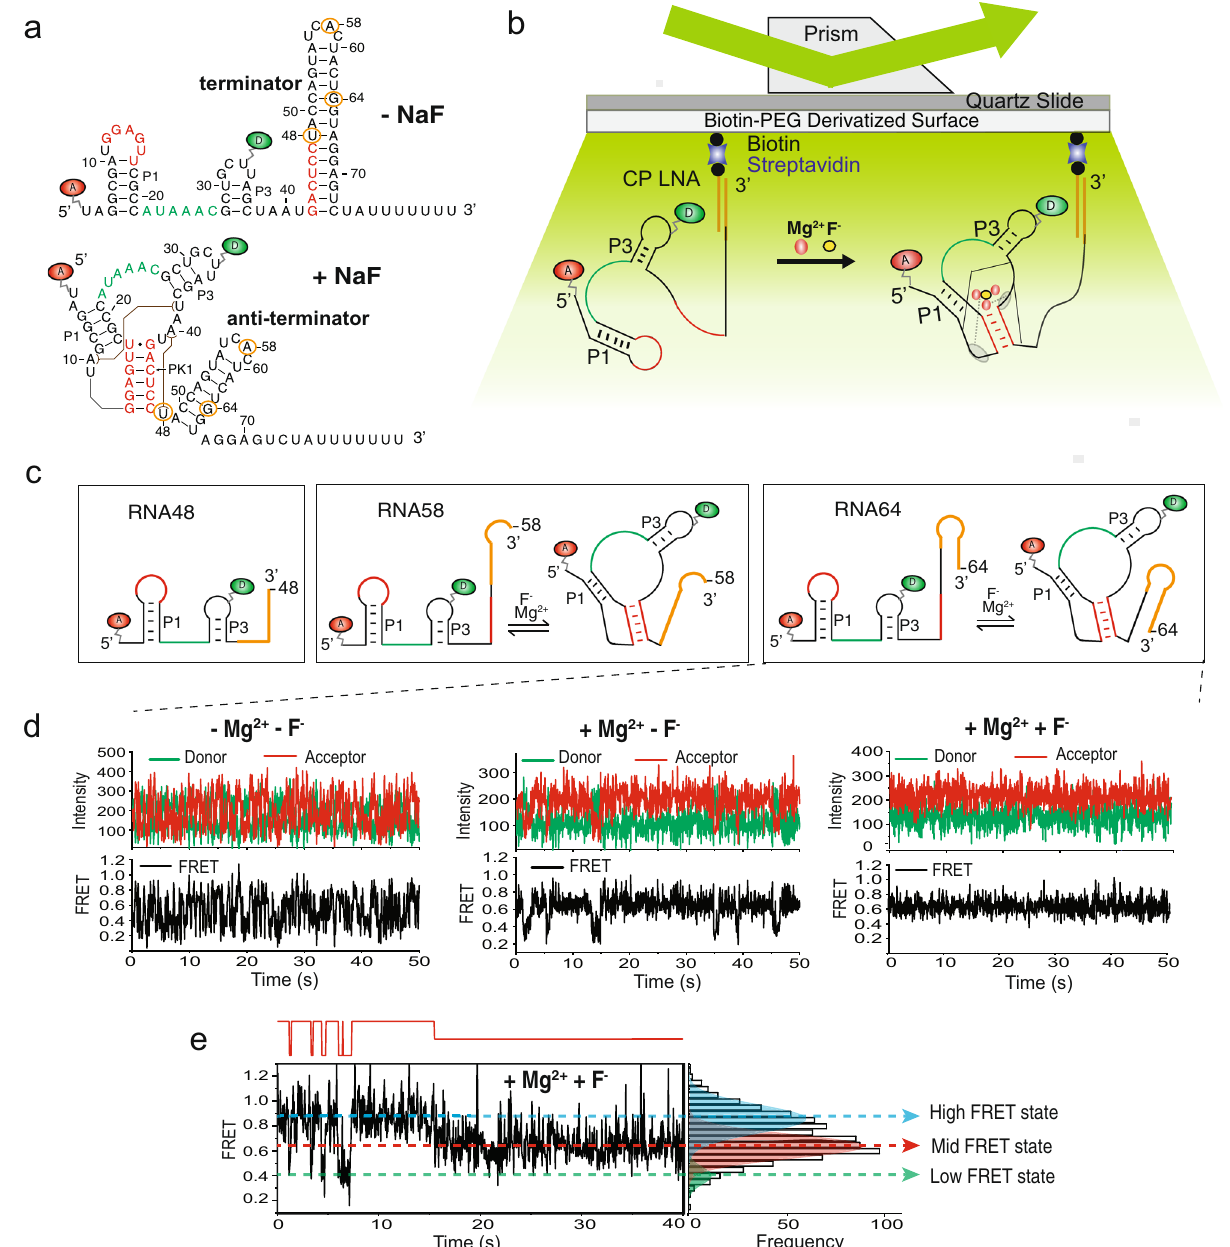
Fig. 1 smFRET analysis of the Bacillus cereus crcB fl uoride riboswitch. a Structure of the fl uoride riboswitch in the absence and presence of fl uoride. The circled nucleotides show the 3 ′ ends of the constructs used for smFRET. The positions of donor and acceptor are shown by green and red ovals labeled D and A, respectively. b Experimental smFRET setup. The RNA is immobilized through a biotinylated LNA capture probe. c The different lengths of RNA used for smFRET. The orange sequence at the 3 ′ end of the riboswitch is complementary to the CP LNA (or bubble DNA, in experiments performed with RNAP as shown in Fig. 4). The red and green segments are a guide to the eye to compare the riboswitch structure in the absence and presence of F - , analogous to the color scheme used in panel a. d Representative smFRET traces for RNA64 in the absence of Mg 2 + and F - (left), in the presence of only Mg 2 + (middle), and in the presence of both Mg 2 + and F - (right). e Example of an RNA64 smFRET trace that transitions between all three FRET states (observed in 5 – 10% of traces in the presence of Mg 2 + only and Mg 2 + plus F - ). The HMM fi t is shown in red above the trace and the FRET distribution of the trace, fi tted with three Gaussian peaks, is shown on the fi tted them using a sum of multiple Gaussian peaks (Fig. 2a, b). eventually saturating at 80% at 5 mM Mg 2 + (Fig. 2a). This Mg 2 + - As expected from our qualitative inspection, the FRET histograms dependence is fi tted well with a Hill equation to yield a half- were best fi tted with three peaks centered at E FRET ≈ 0.35, 0.69, saturation point of K 1/2 ~ 1 mM and a cooperativity coef fi cient of and 0.83 in the absence of Mg 2 + , and similarly E FRET ≈ 0.35, 0.63, n = 2.1 (Supplementary Fig. 4). Taken together, these observa- and 0.85 in the presence of 5 mM Mg 2 + . With Mg 2 + , however, tions provide further evidence that the mid-FRET is the Mg 2 + - the mid-FRET D state becomes more populated, increasing from dependent docked D state and requires multiple Mg 2 + ions to form. ~36% in the absence of Mg 2 + to 56% in 1 mM Mg 2 + , and